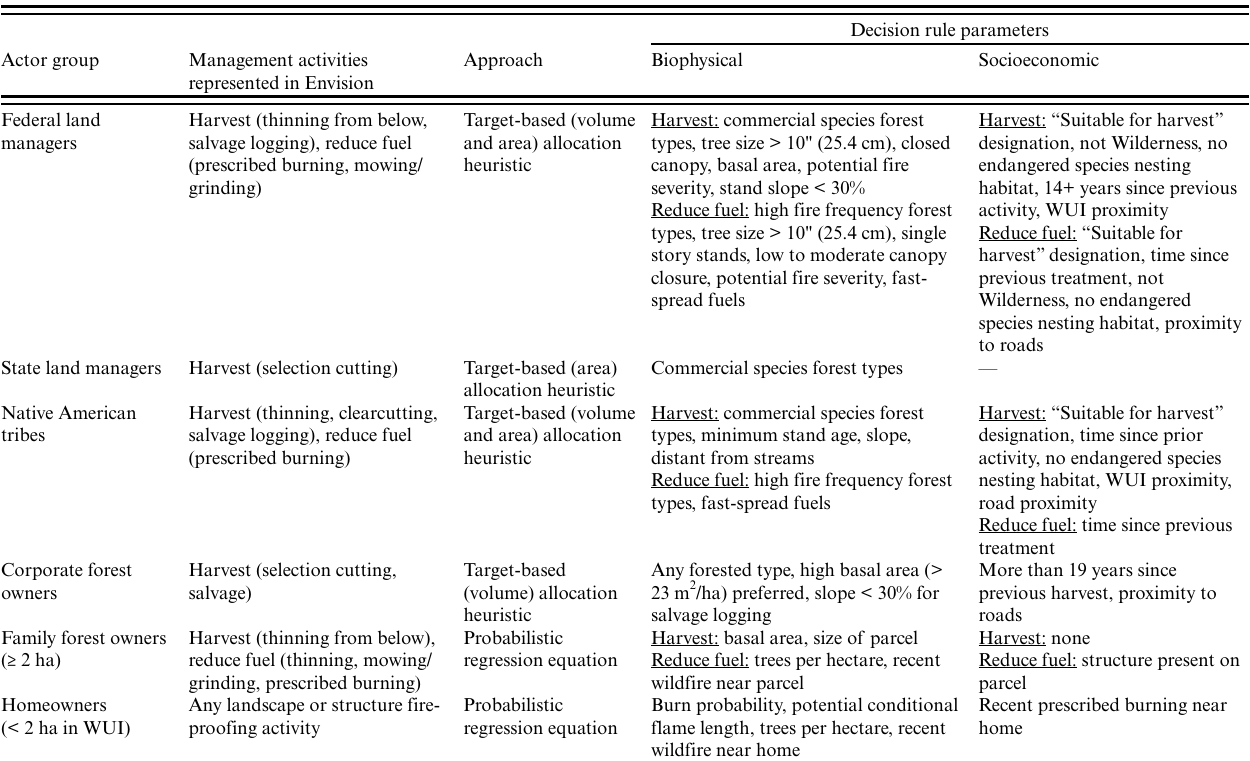
Table 3 . Representation of actors’ forest management and wildfire risk mitigation activities in the agent-based model Envision (WUI: wildland–urban